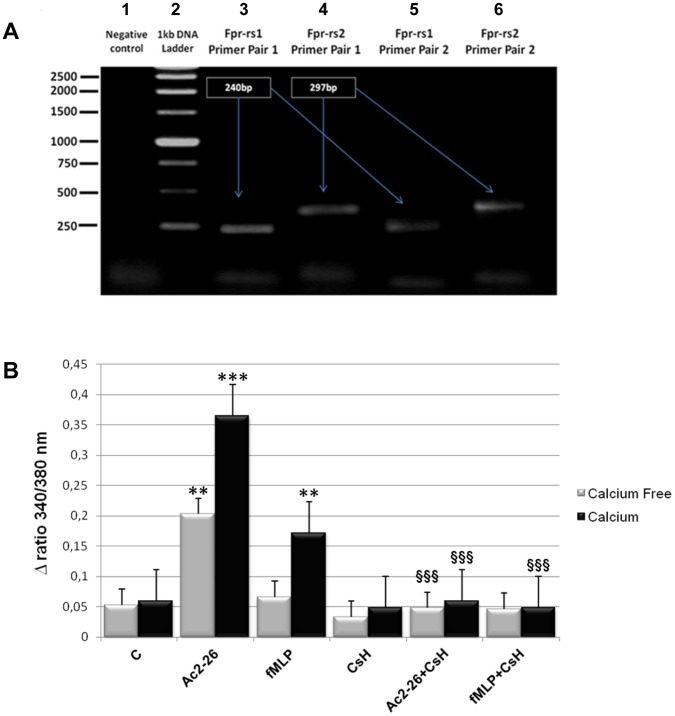
FPR detection and effects of Ac2-26, fMLP and CsH on the FPR-induced rise in intracellular Ca2+. (A)Qualitative PCR products for full-length Fpr-rs1 and Fpr-rs2 genes with only cDNA isolated from C2C12 cells. Product electrophoresis was performed on 1% agarose gel stained with ethidium bromide. Lane 1: negative control. Lane 2∶1 kb DNA ladder. Lane 3: primer pairs 1 for Fpr-rs1 amplicon, 240 bp. Lane 4: primer pairs 1 for Fpr-rs2 amplicon, 297 bp. Lane 5: primer pairs 2 for Fpr-rs1 amplicon, 240 bp. Lane 6: primer pairs 2 for Fpr-rs2 amplicon, 297 bp. (B) C2C12 were treated as described in Materials and Methods. The histogram shows the fluorescence ratio calculated as F340/F380 nm in the presence or in the absence of extracellular Ca2+.Control represents unstimulated cells. Data are means ± SEM (n = 3). *** <0.001, ** <0.01 vs corresponding controls; §§§ <0.001 vs Ac 2-26 or fMLP.